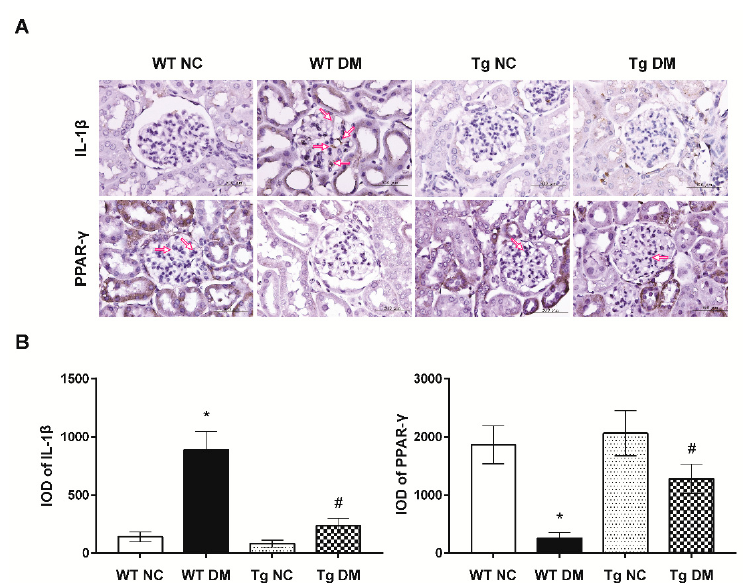
Figure 3. ( A ) Representative photographs of the immunohistochemical (IHC) staining for IL-1 β and PPAR- γ in the renal cortex of study animals. Arrows indicate positive staining over mesangial cells or the mesangium. ( B ) The integrated optical density (IOD) of IL-1 β and PPAR- γ IHC-stained materials were analyzed utilizing the Image Pro Plus software. IOD = optical intensity of positive cells × area of positive cells. Data from histomorphometric analysis are presented as means ± standard errors calculated from six independent experiments. The symbol * indicates significant difference vs. the WT NC group ( p < 0.05); the symbol # indicates significant difference vs. the WT DM group ( p < 0.05).